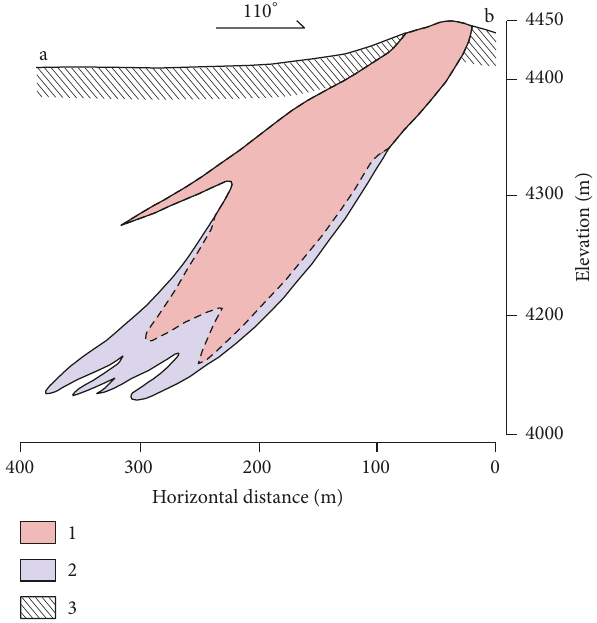
Figure 2: The cross section of number 134 pegmatite dike in Jiajika deposit. 1: spodumene zone, 2: albite zone, and 3: altered crystalline schist. The arrow direction of 110 ∘ is the direction of cross section. The labels “a” and “b” correspond to the “a” and “b” shown in Figure 1 for the cross section.